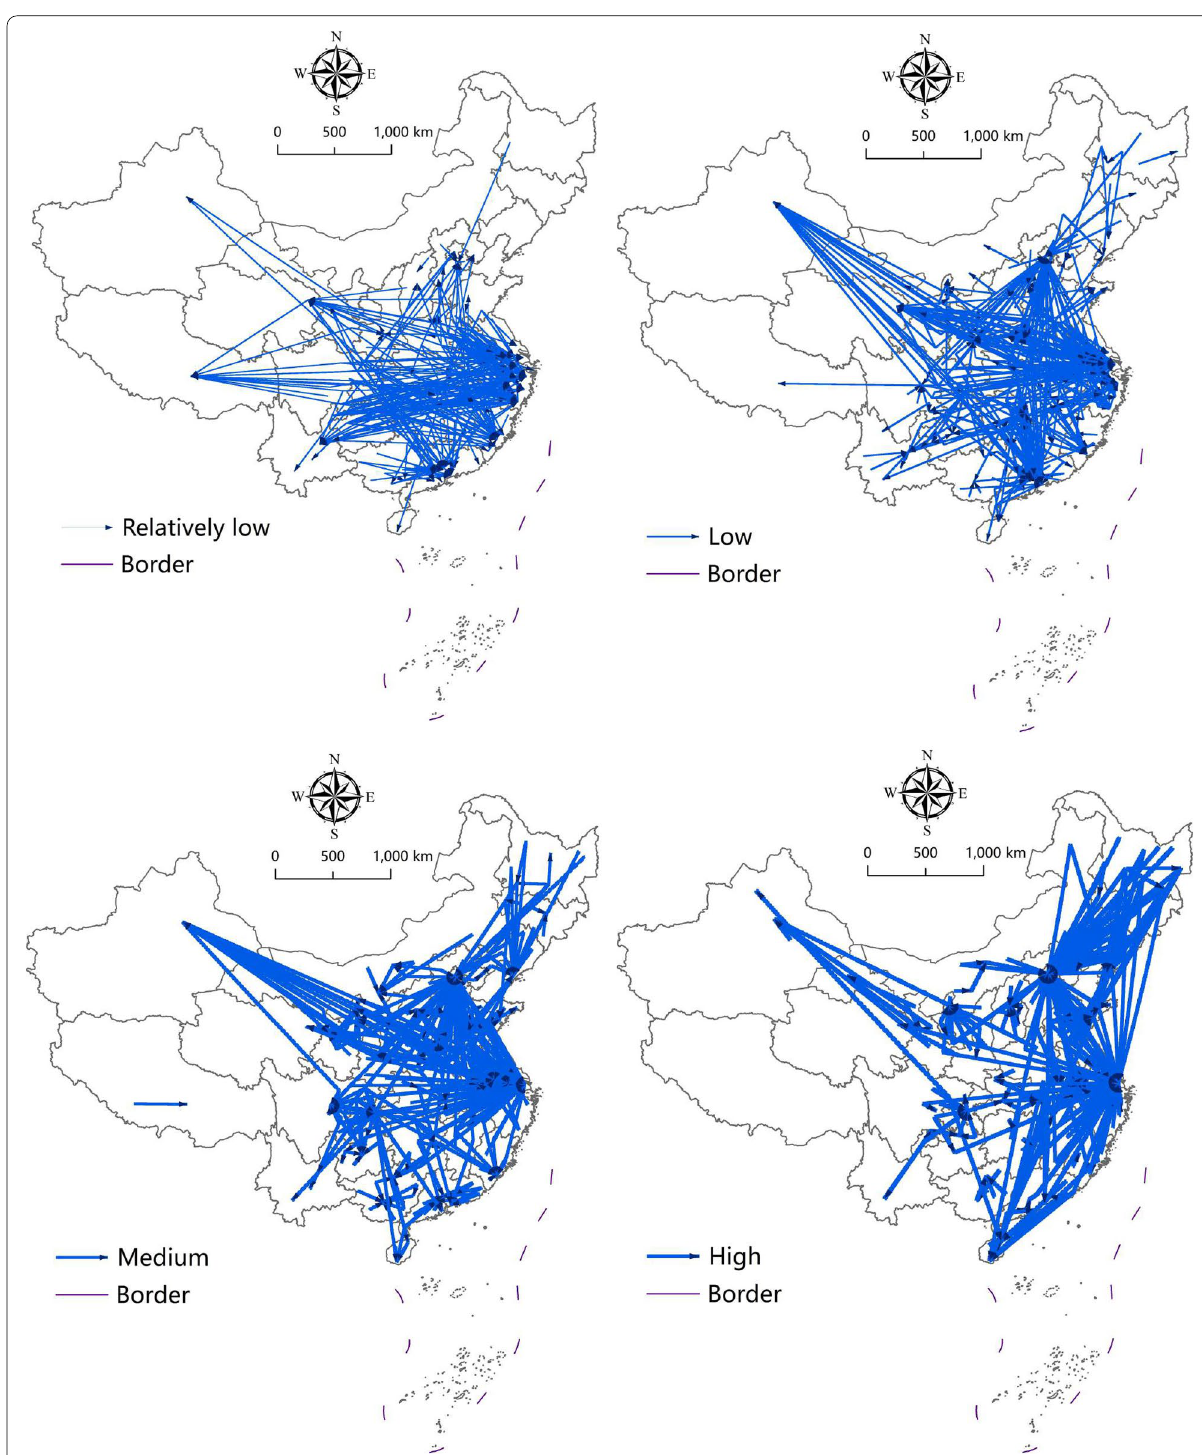
Fig. 6 Settlement intention flow at different levels. Data source: China Migrants Dynamic Survey (CMDS;